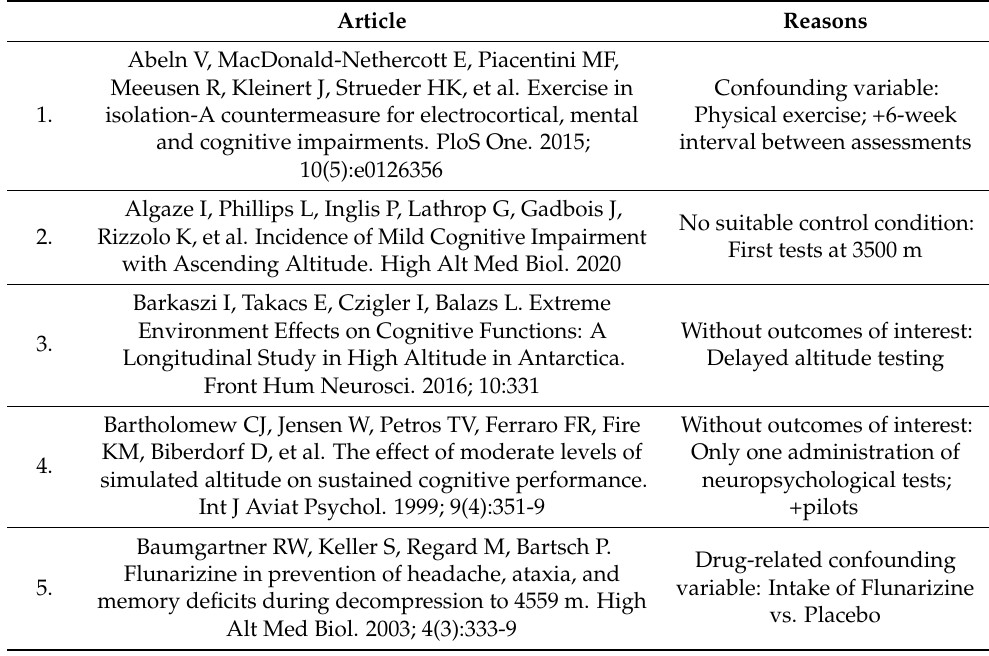
Table A1. Excluded articles and their reasons for being ruled